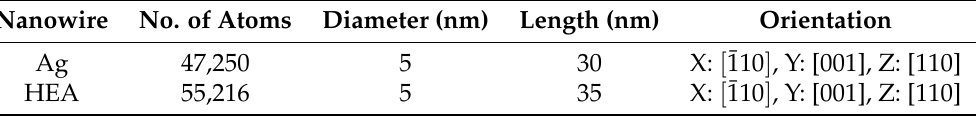
Table 1. Crystallographic details of the Ag and CoNiCrFeMn HEA nanowires at different temperatures.